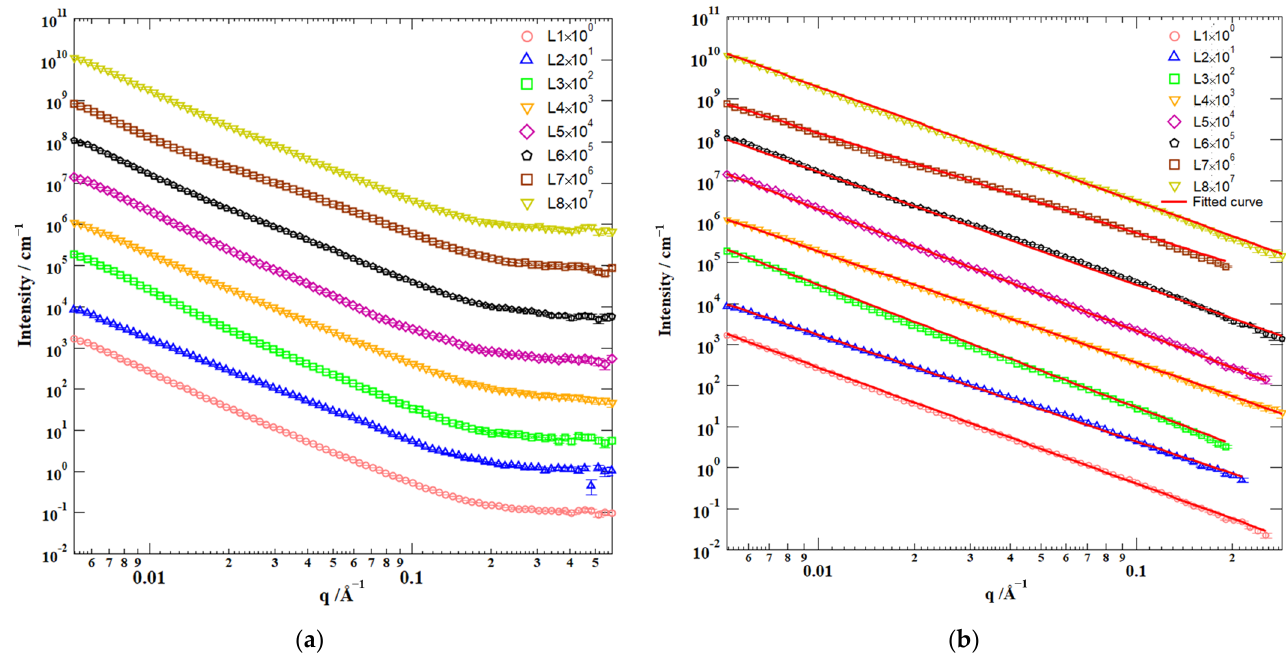
Figure 3. Scattering intensity curve of the deep shale samples: ( a ) original scattering intensity curve and ( b ) scattering intensity curve with background signal removed.